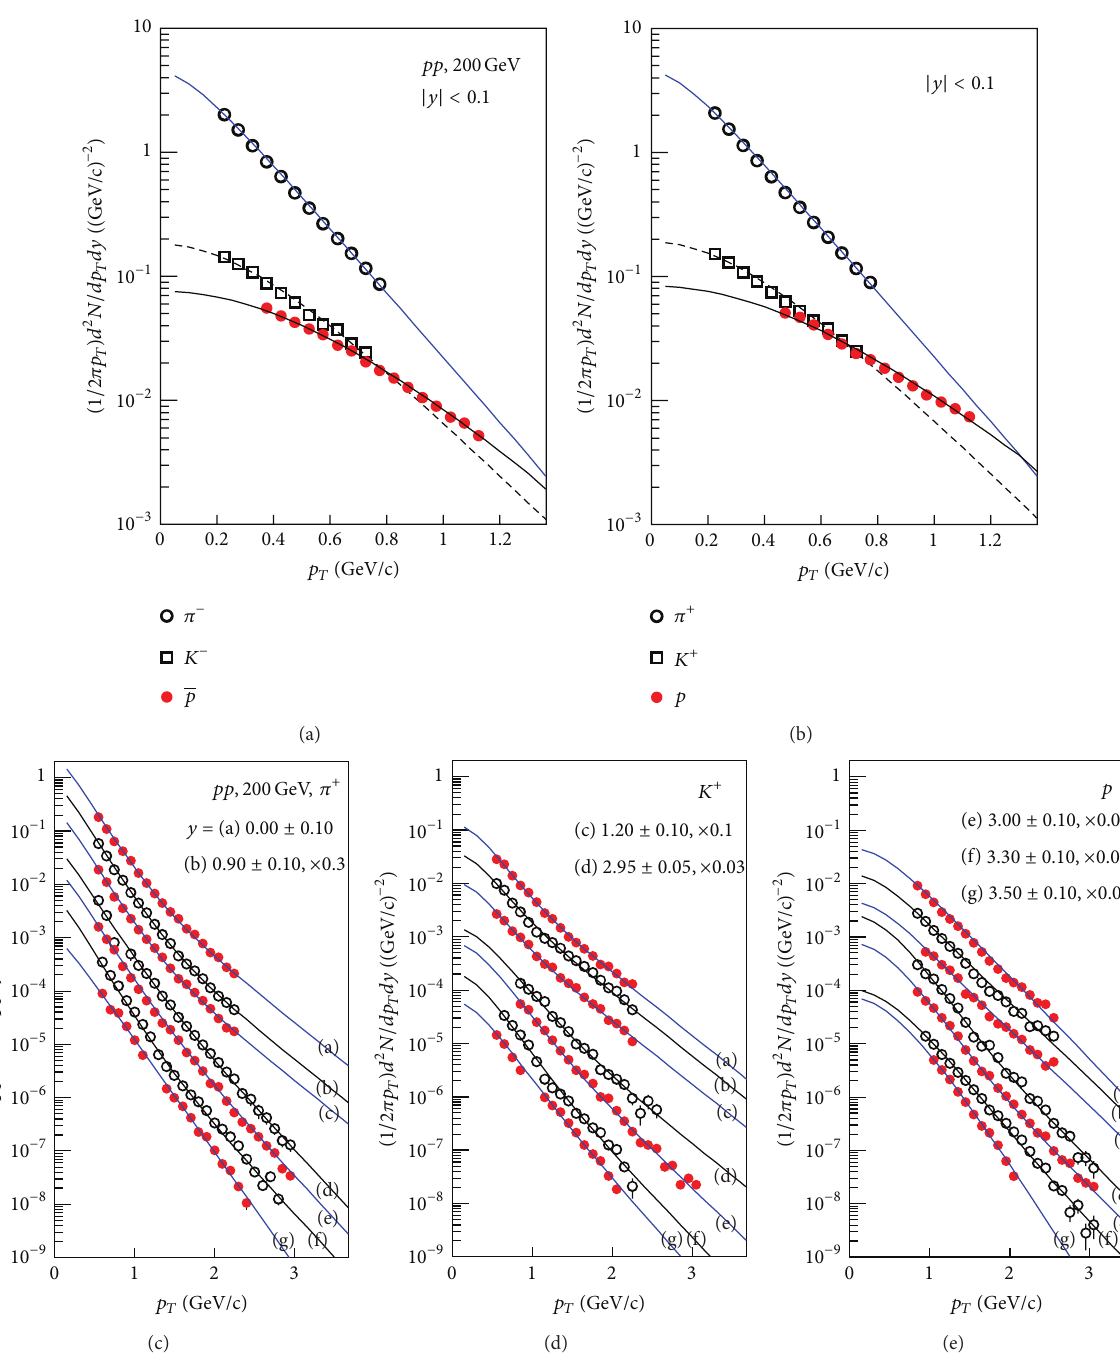
Figure 1: The transverse momentum distributions of (a) 𝜋 − , 𝐾 − , and 𝑝 , (b) 𝜋 + , 𝐾 + , and 𝑝 , (c) 𝜋 + , (d) 𝐾 + , and (e) 𝑝 produced in 𝑝𝑝 collision at √𝑠 = 200 GeV with different y ranges and magnifications are shown in the figure. The symbols represent the experimental data of the STAR [26] and BRAHMS Collaborations [27] and the curves are our results calculated by the Boltzmann or two-component Boltzmann